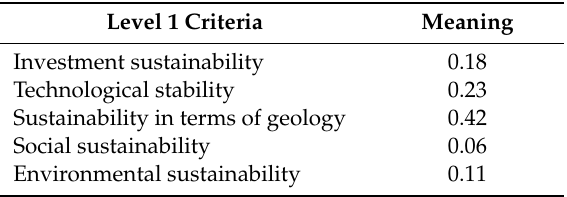
Table 5. Calculation of the first level criteria priority